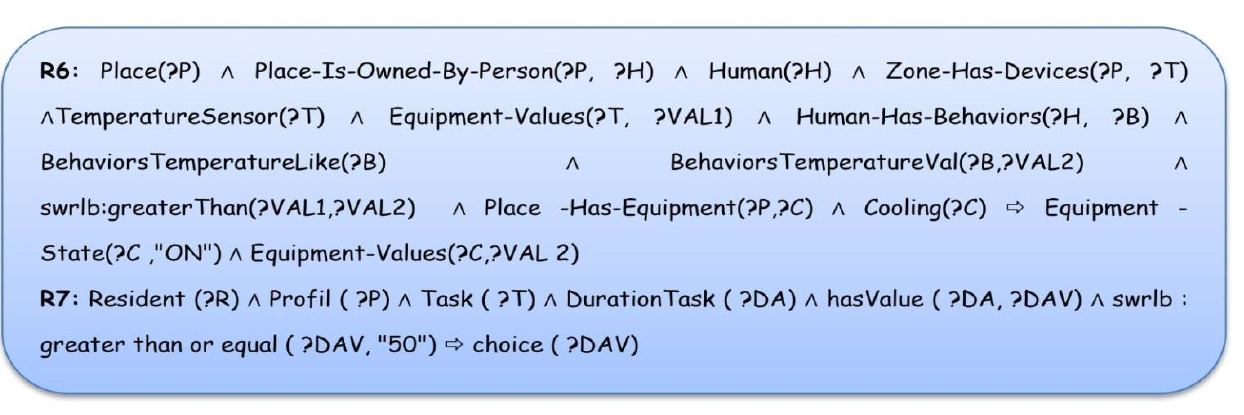
Figure 7. Rule 6 and Rule 7.